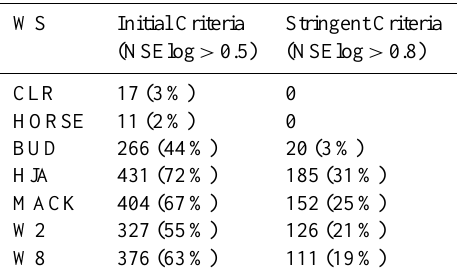
Table 2. Number of acceptable parameters sets for each watershed. Table 3. Example of an acceptable parameter set across common geologic